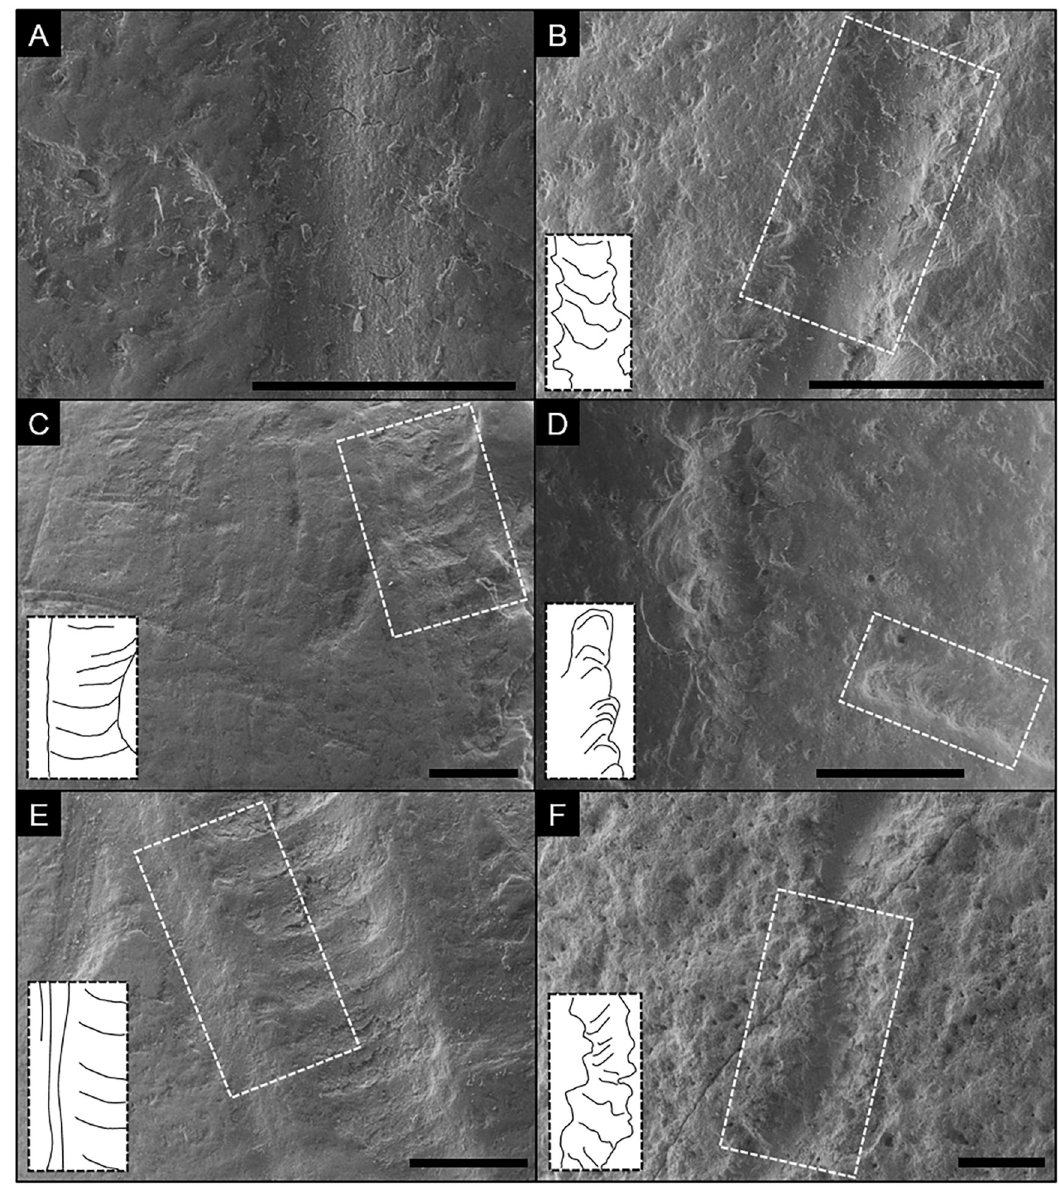
Fig 2. Comparison of carnivore-induced tooth scores (left column) and air-scribe-induced grooves (right column) under SEM. Insets are interpretive drawings of highlighted areas. A) Segment of a smooth tooth score with relatively smooth margins and faint, internal grooves exhibiting continuity on a bovid long bone; scale bar = 0.5 mm. B) Segment of a transition within an air-scribe groove from a chatter-like morphology (upper half) into a smooth-based groove on a fossilized bone fragment; scale bar = 1.0 mm; Notice the rougher margins in comparison to A. C) Shallow tooth score with chatter marks, a smooth left margin, and an irregular right margin on a bovid long bone; scale bar = 1.0 mm. D) shallow (lower left) and deep (top to bottom) air-scribe grooves on a fossilized bone fragment; scale bar = 1.0 mm. Notice the similarities between the chatter morphology of the lower-left mark and the scores depicted in C and E. Also note the relatively rougher margins. E) Tooth score with pronounced chatter markings and a long- axis-parallel, smooth left shoulder with through-going continuity on a bovid long bone; scale bar = 1.0 mm. F) sinuous air-scribe groove with faint chatter marks, rough margins, and an absence of through-going continuity on a fragment of a chelonian carapace; scale bar = 1.0